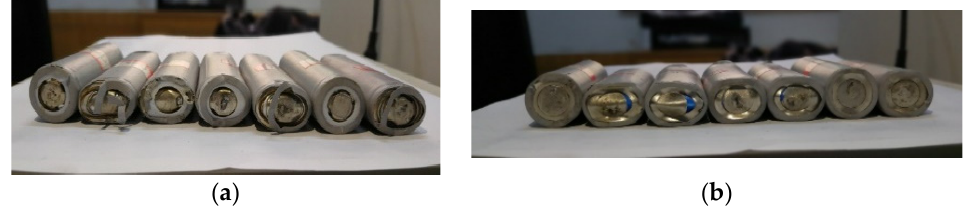
Figure 6. Deformed batteries: ( a ) positive electrode; ( b ) negative electrode.